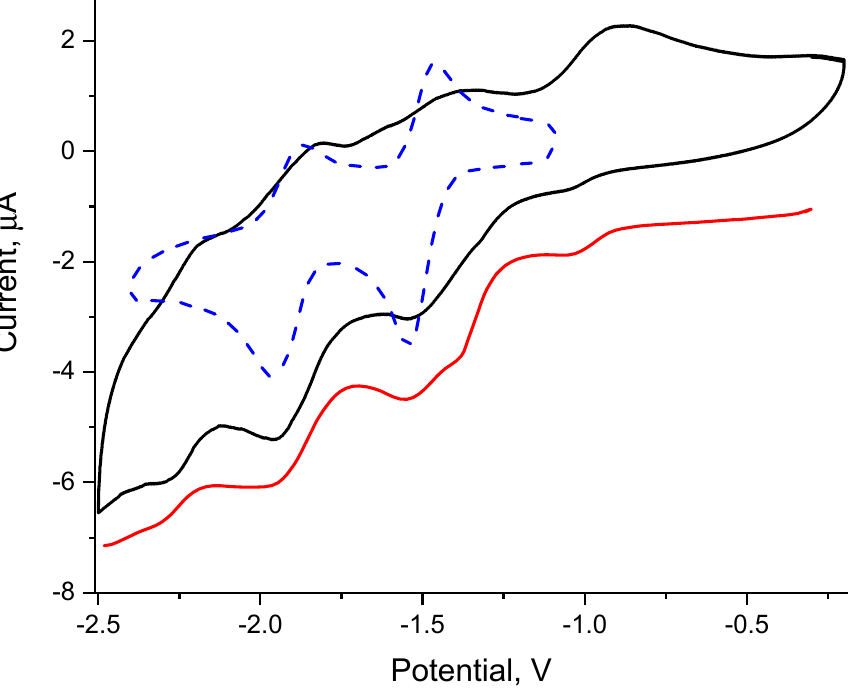
Figure 9. CV for trans -[Re 6 S 8 (bpe) 4 Cl 2 ] (solid black) and free bpe (dotted blue). Square-wave voltammetry for trans -[Re 6 S 8 (bpe) 4 Cl 2 ] (solid red). All measurements were carried out in DMSO, electrolyte: 0.1 M Bu 4 NBF 4 , CV scan rate: 100 mV/s.